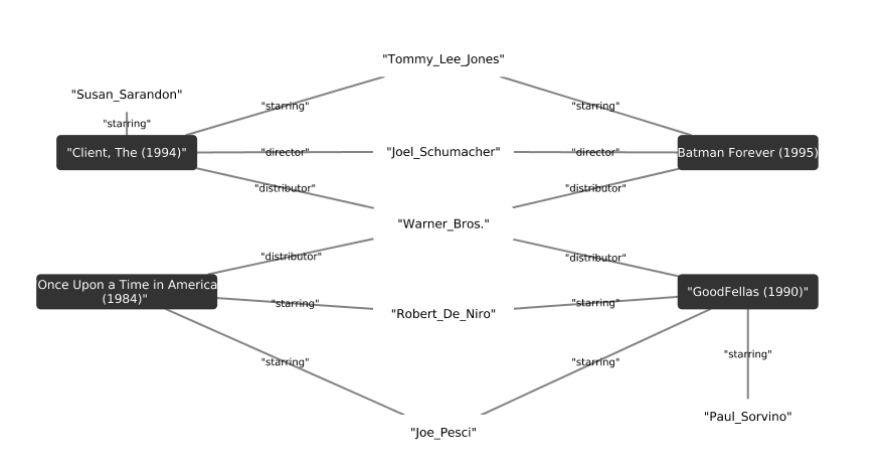
Figure 6. An example of movies from the MovieLens dataset that shows the relations of the movies using the DBpedia knowledge graphs. The black squares show the movie title, the edges are the properties and the white nodes are the property